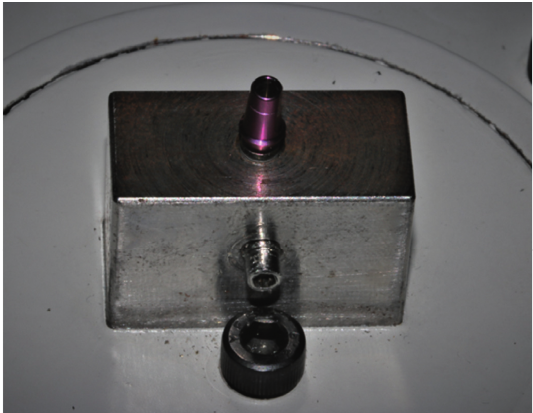
Figure 1: Prosthetic interface fixed in the test base.